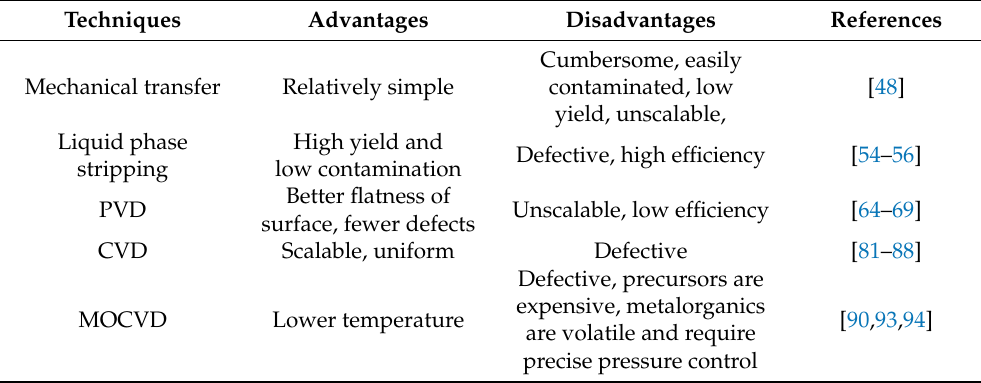
Table 1. Advantages and disadvantages of different fabrication techniques.